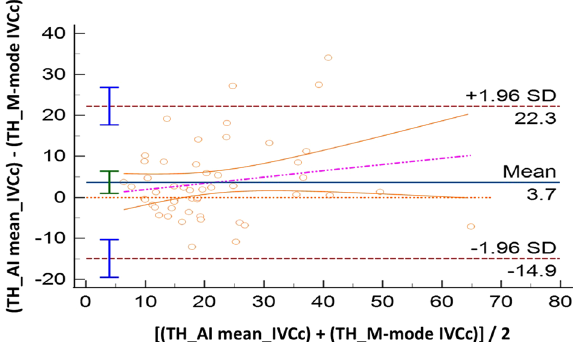
Fig. 2 Bland–Altman plot for the inferior vena cava collapsibility index (IVCc) measured in Transhepatic (TH) site with standard M-mode or artificial intelligence (AI). SD: standard